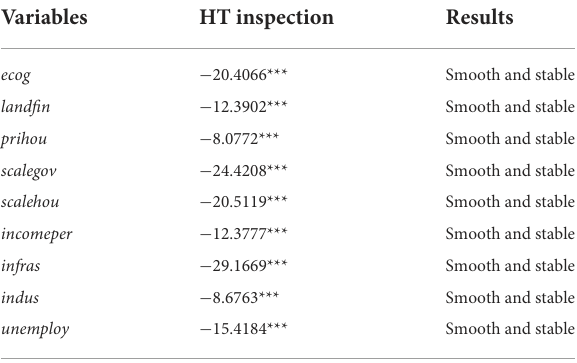
TABLE 3 Unit root test